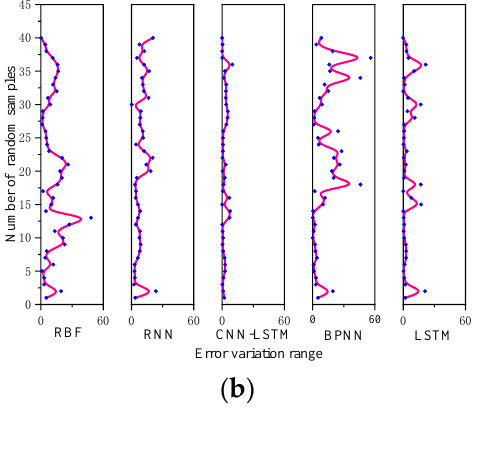
Table 5. Comparison of predicted values and real values of typical single wells.